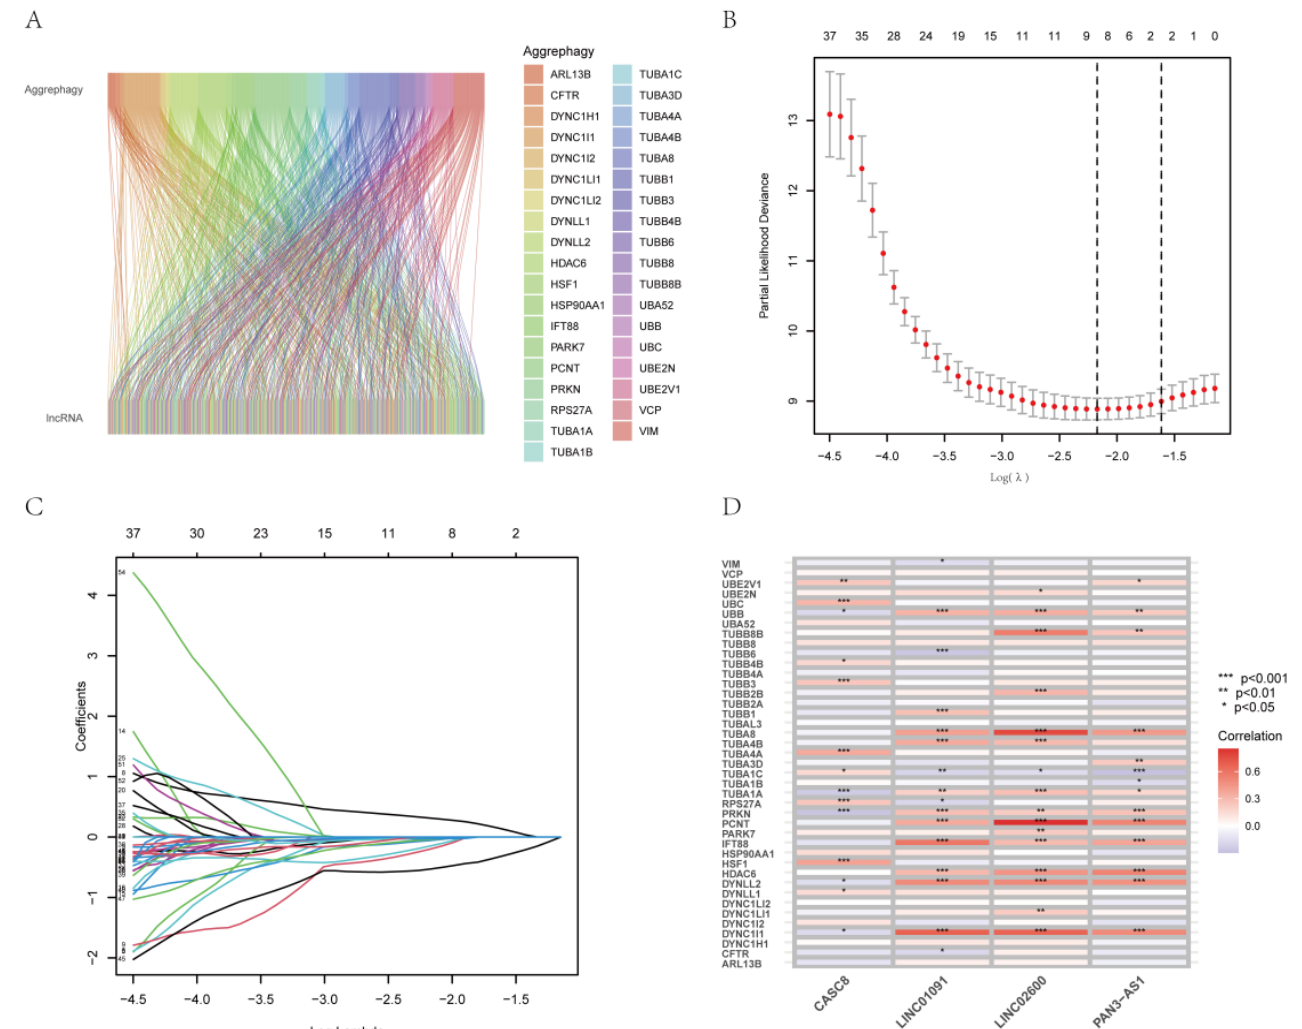
Figure 2. Pancreatic adenocarcinoma aggrephagy-related lncRNA signature construction. ( A ) The Sankey figure shows the correlation between AGGLncRNAs and ARGs. ( B ) In the left diagram, the LASSO Cox regression model shows versus log( λ ) of the partial likelihood of deviance. ( C ) The lambda parameter shows the coefficients for certain characteristics. The lambda parameter represents the coefficients of the extracted features. The horizontal coordinate demonstrates the effect on the independent variable lambda and the vertical coordinate denotes the coefficient of the independent variable. ( D ) The heat map depicts the co-expression association between AGGLncRNAs and ARGs; asterisks highlight the degree of